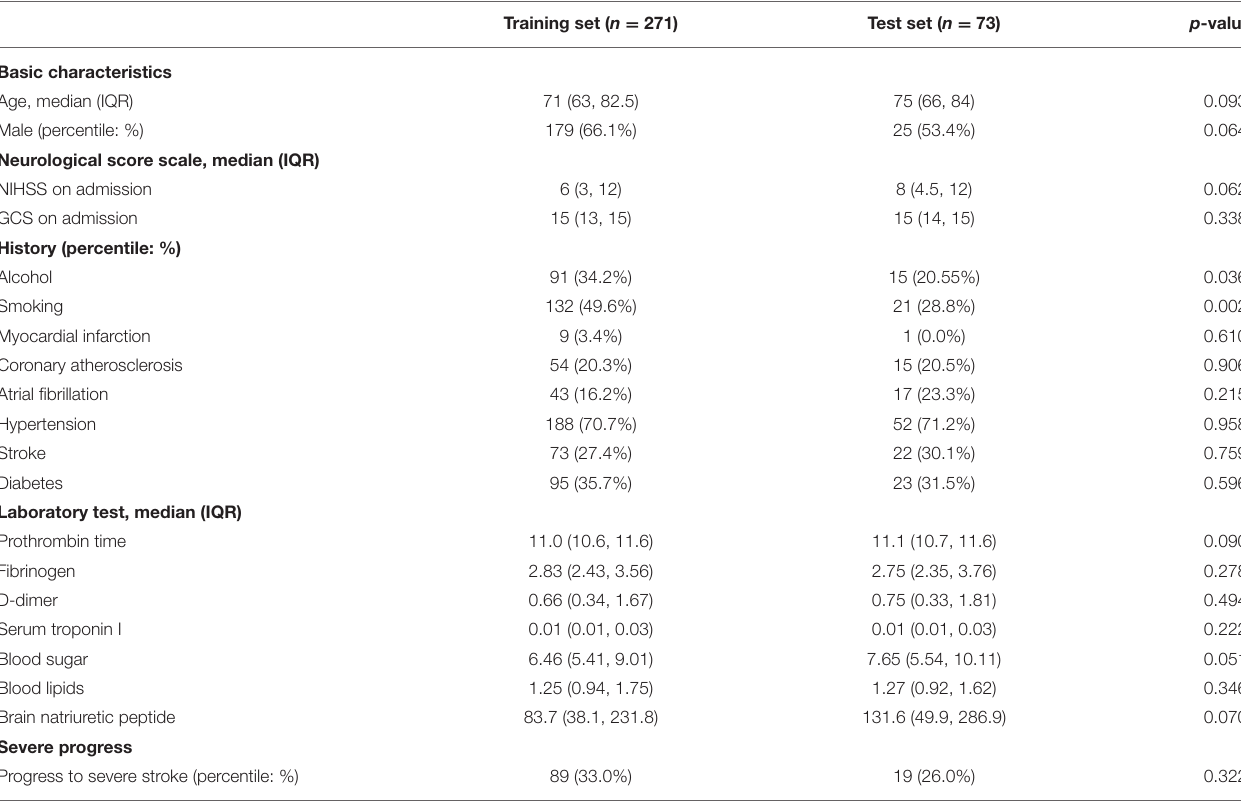
TABLE 1 | Basic patient information. Training set ( n = 271) p -values